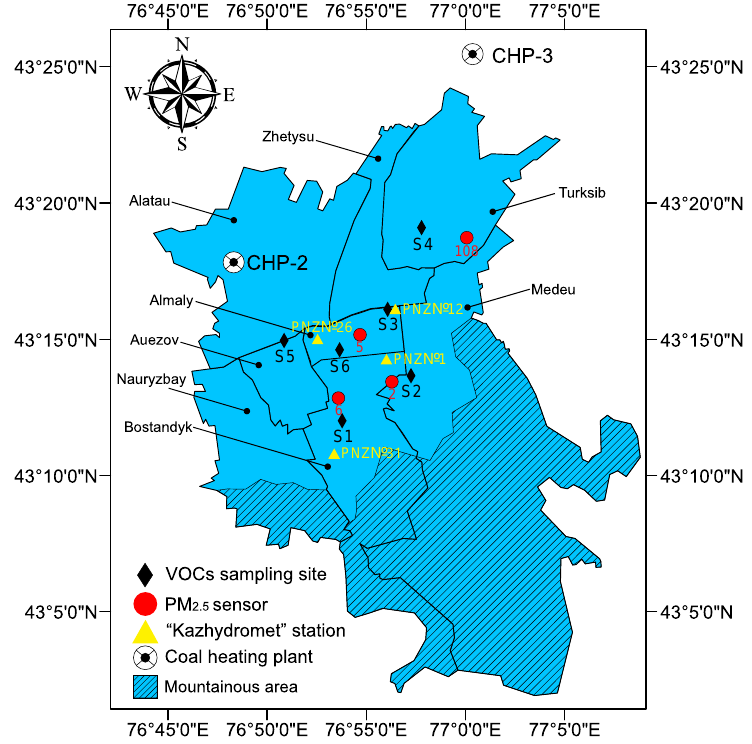
Figure 1. Map showing the location of the sampling sites in Almaty, Kazakhstan. Average temperatures in sampling periods in winter, spring, summer, and autumn in Almaty in 2020 were − 5.7, 15.8, 24.3, and 9.3 °C, respectively. The heating season in Concentrations of NO 2 , SO 2 , and CO were obtained from The National Air Quality Monitoring Network (NAQMN) operated by the National Hydrometeorological Service